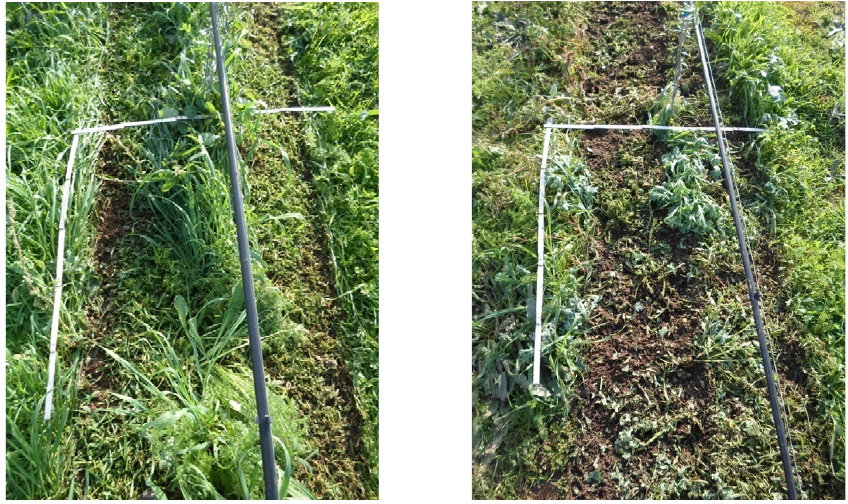
Figure 4. Weed soil coverage (%) immediately after the Grass Killer test on 11 November 2020. Left and right picture represent GK 2.7 and GK 1.2 forward speeds, respectively.